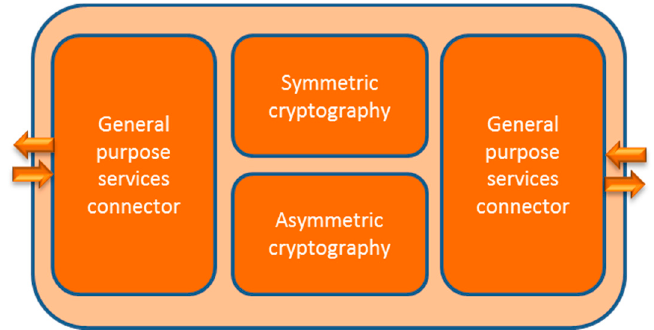
Figure 7. Data processing done in the Security module.